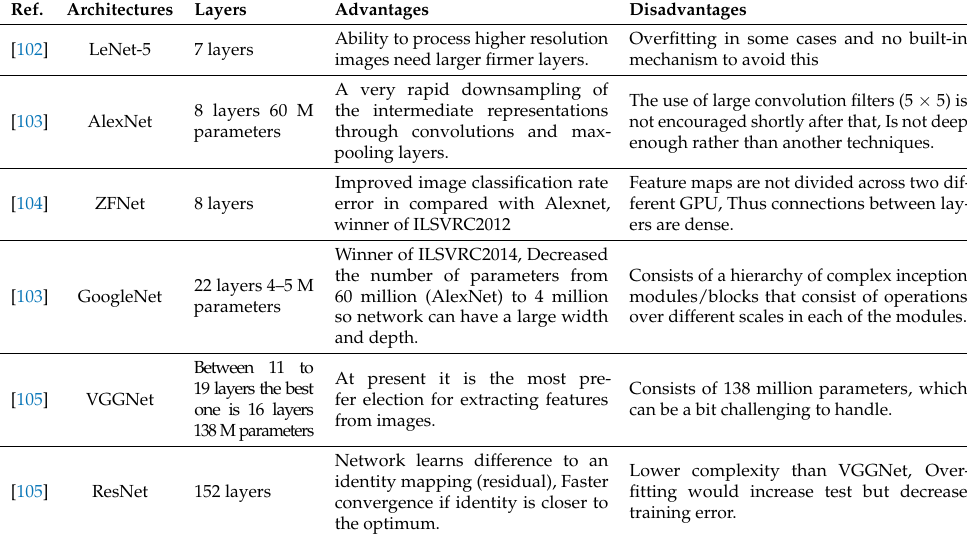
Table 5. Comparison of different architecture of CNN.